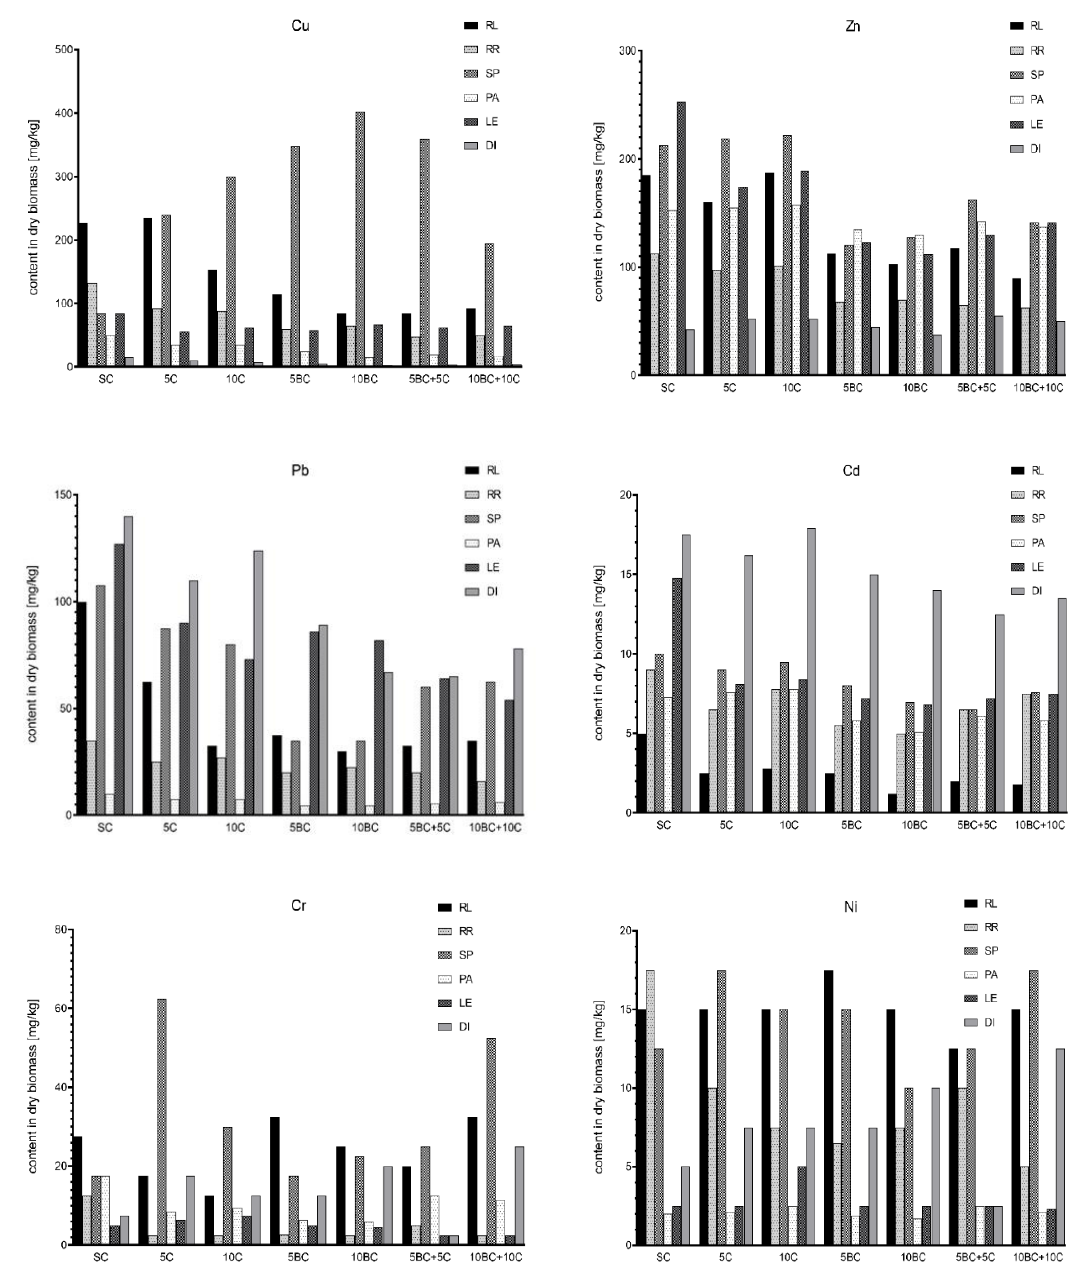
Figure 4. Content of Cu, Zn, Pb, Cd, Cr and Ni in vegetables grown on soil amended with biochar, compost and their combination. RL, radish leaf; RR, radish root; SP, spinach; PA, parsley; LE, lettuce; DI, dill. Abbreviations of the treatments are defined in Table 3.